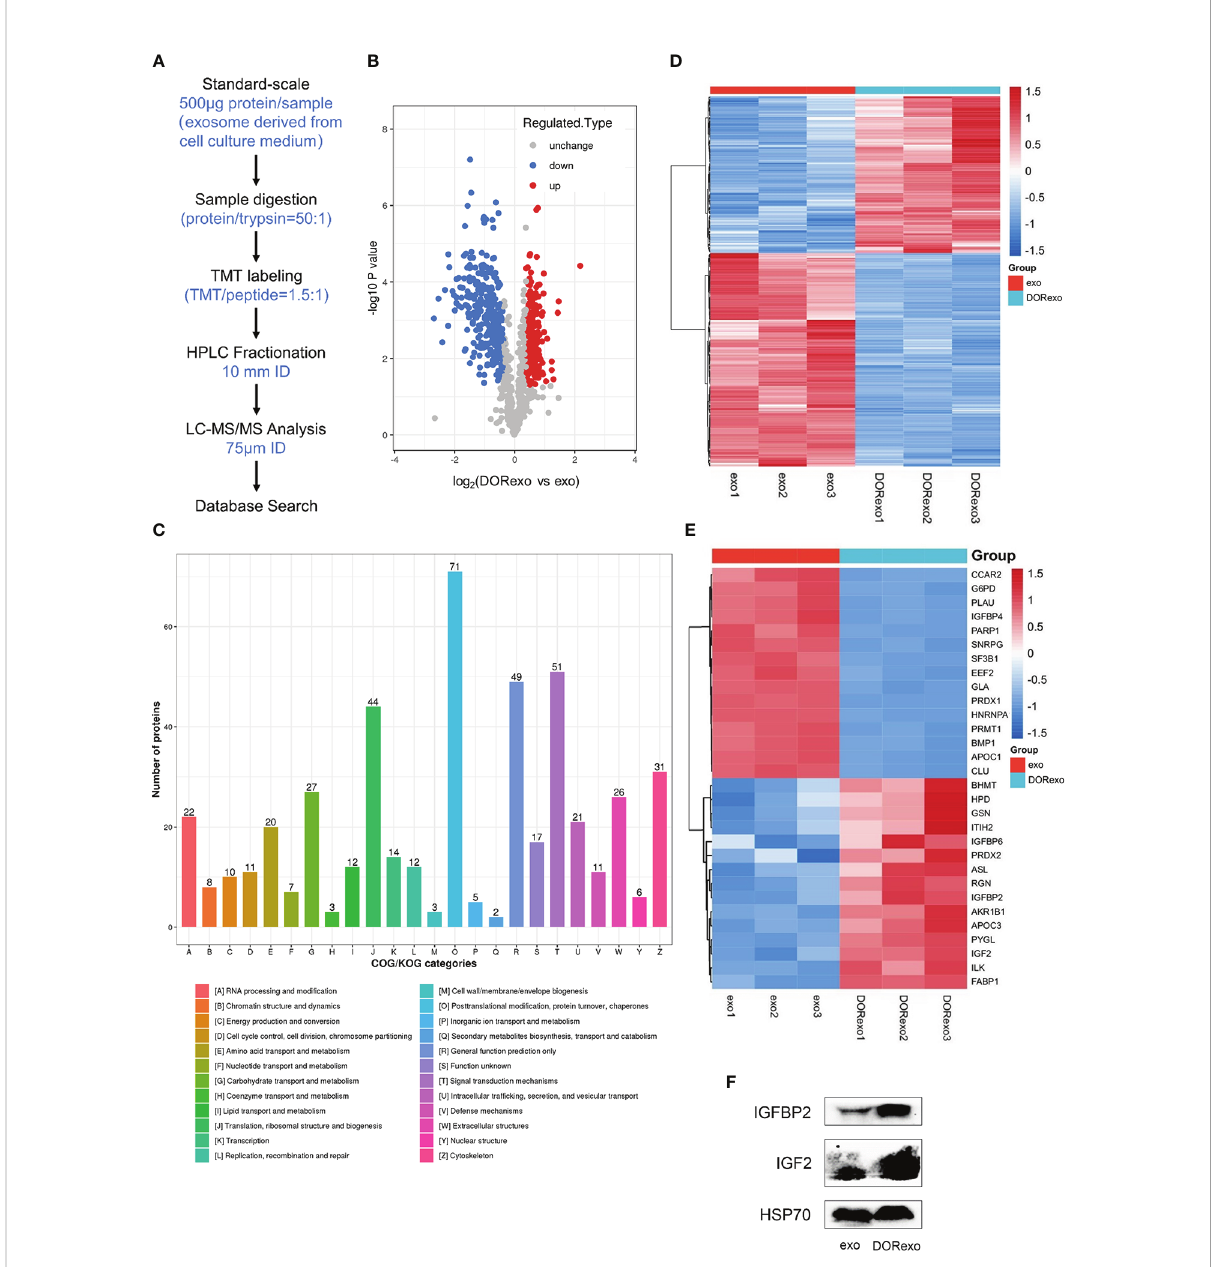
FIGURE 2 Proteomic analysis of the differential protein in dormant A549 cell exosomes. (A) The analysis pipeline of proteomics was shown. (B) The volcano plot was shown. Red dots indicate expressed upregulated proteins, and blue dots indicate expressed downregulated proteins. (C) Gene Ontology was performed on differentially expressed exosome proteins. The differentially expressed proteins were enriched in the Clusters of Orthologous Groups of protein/EuKaryotic Orthologous Groups (COG/KOG) categories. (D) Heat map showed the enrichment of 394 proteins involved in metabolic processes. (E) Heat map showed the enrichment of proteins involved in the cellular metabolic processes and in the IGF signaling pathway. (F) IGFBP2 and IGF-2 were analyzed by Western blotting exo, exosomes from untreated A549 cells; DORexo, exosomes from dormant A549